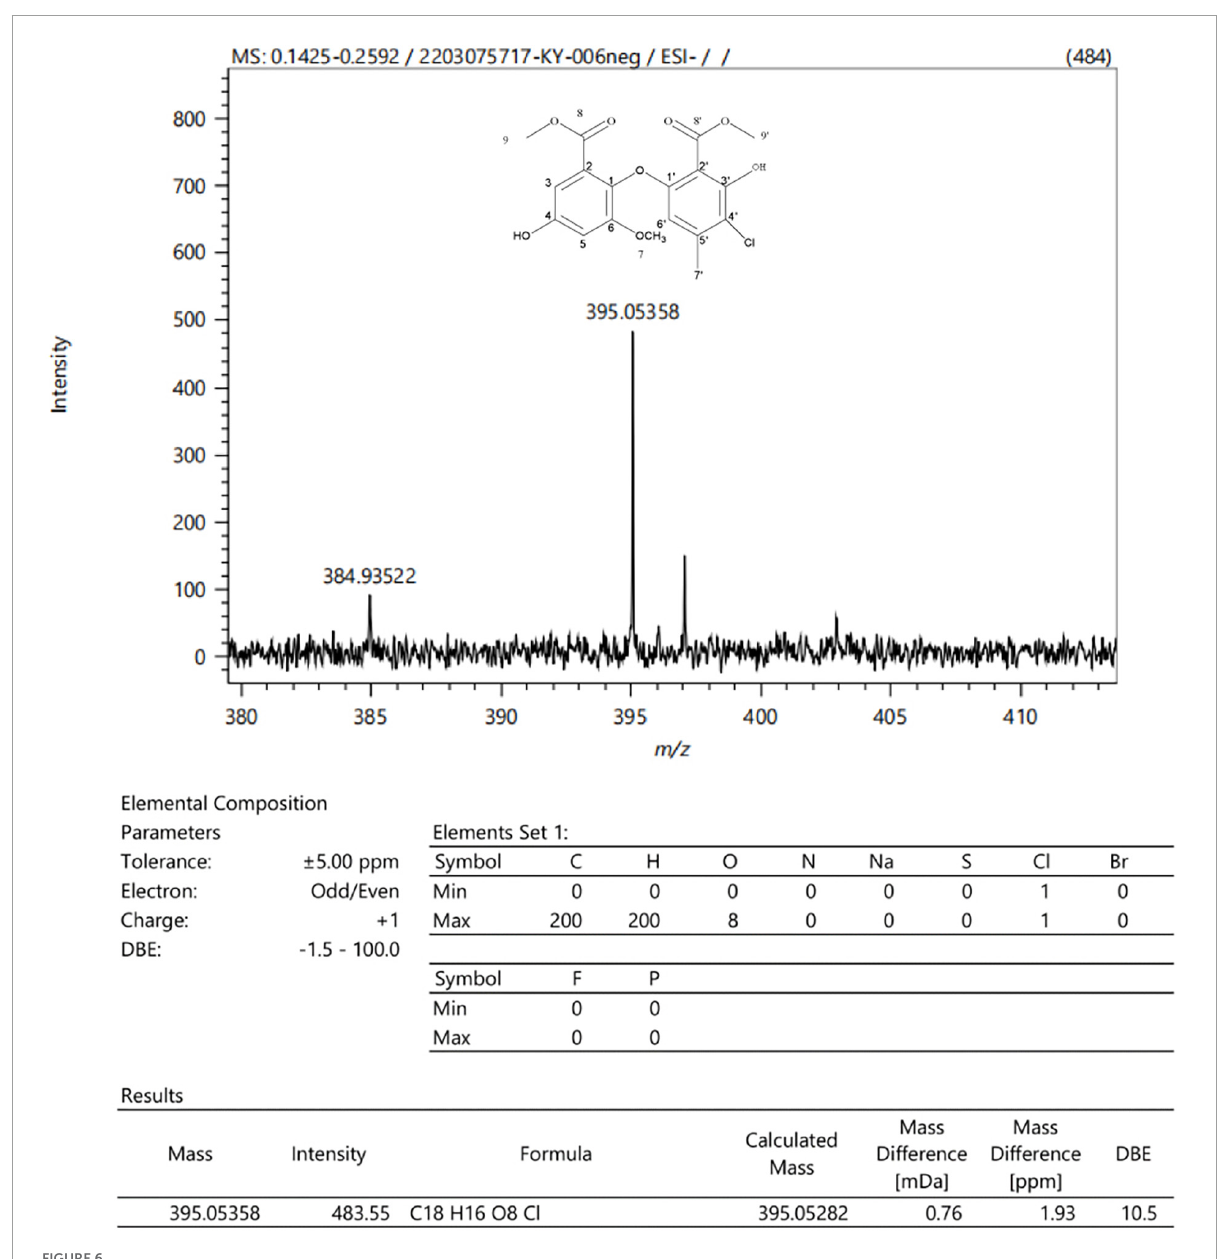
FIGURE6 ESI-MS chromatogram and molecular formula of the monomer component isolated from the ethyl acetate (EA) crude extracts of Penicillium macrosclerotiorum